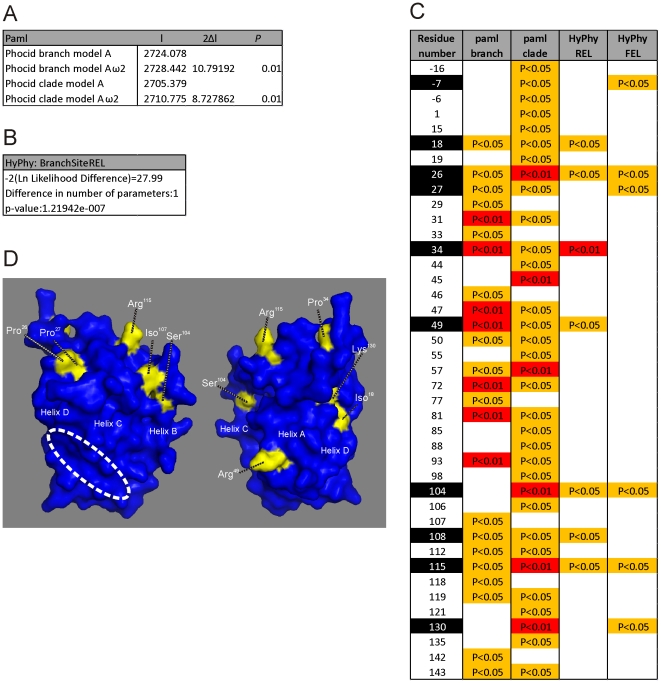
Positively selected residues in the phocid seal leptin occur away from the LEPR binding cleft.Likelihood ratio test statistics generated from the PAML branch model (A) and the REL analysis implemented using HyPhy (B) using the phocid branch of the tree. C shows the residues predicted to be under positive selection and statistical support by Bayes Empirical Bayes implemented in PAML and HyPhy REL and FEL analysis. D. Two views of the grey seal leptin with the selected residues identified in yellow and individually labelled. The positions of the A, C and D helices are indicated. The position of the hydrophobic binding cleft is identified with the white ellipse.